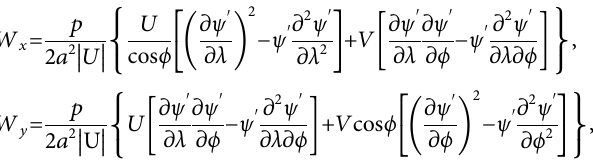
Frontiers in Environmental Science |